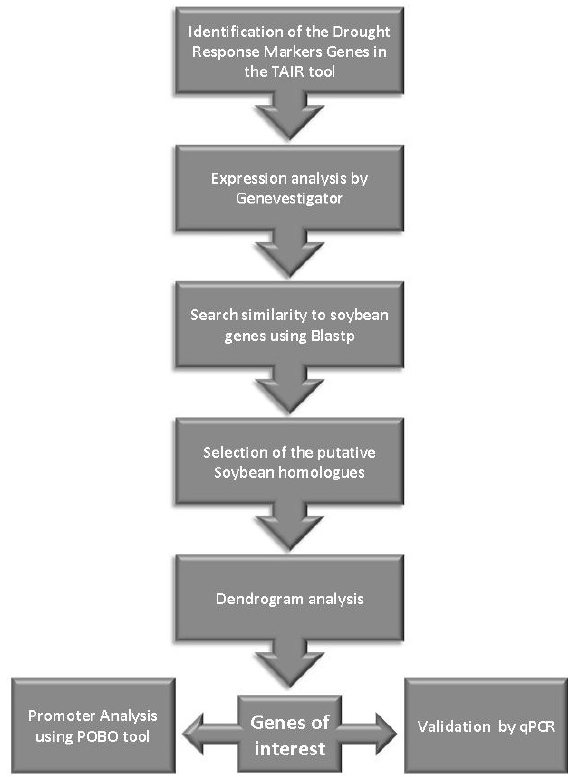
Figure S1 - Search strategy for DMGs involved in the soybean response to water